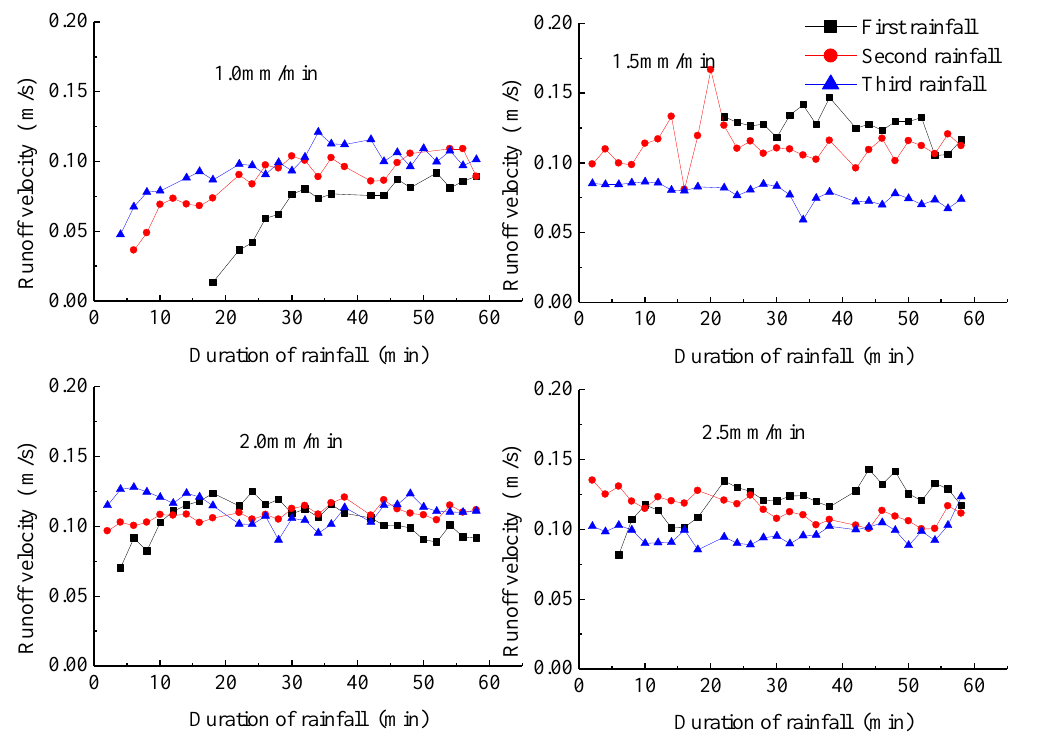
Figure 13. Variation curve of runoff velocity with time of the sand-covered slope at different rainfall densities.